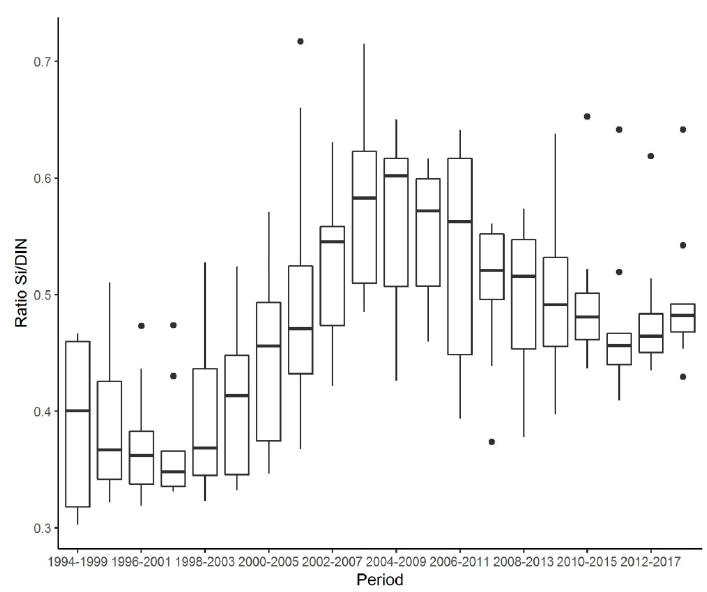
Figure 14. Boxplot of the Dissolved Silica (DSi) / Dissolved Inorganic Nitrogen (DIN) ratio by six-year sliding period, merged for all study sites. Input values for both variables are averaged maxima by period, calculated during the winter season for both DSi and